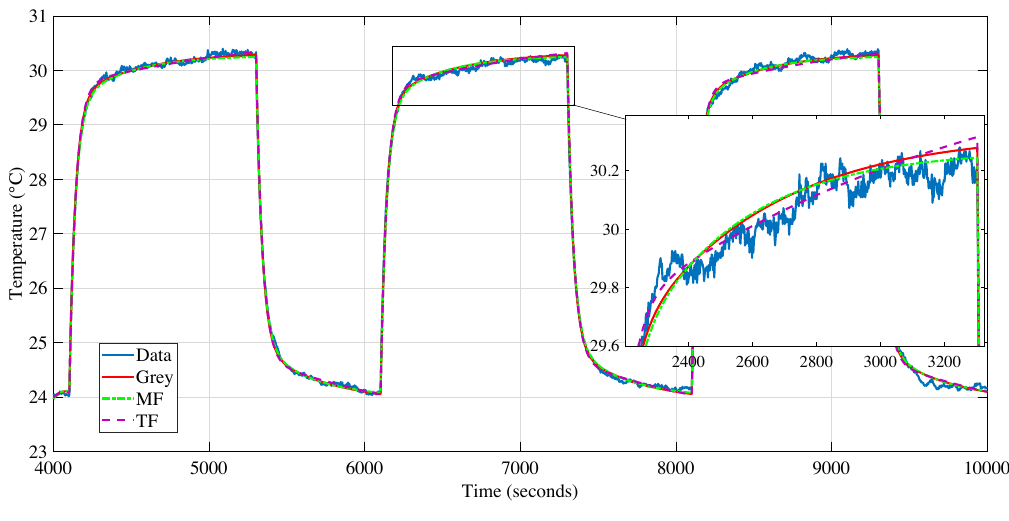
Figure 9: Validation - measured vs. simulated model output